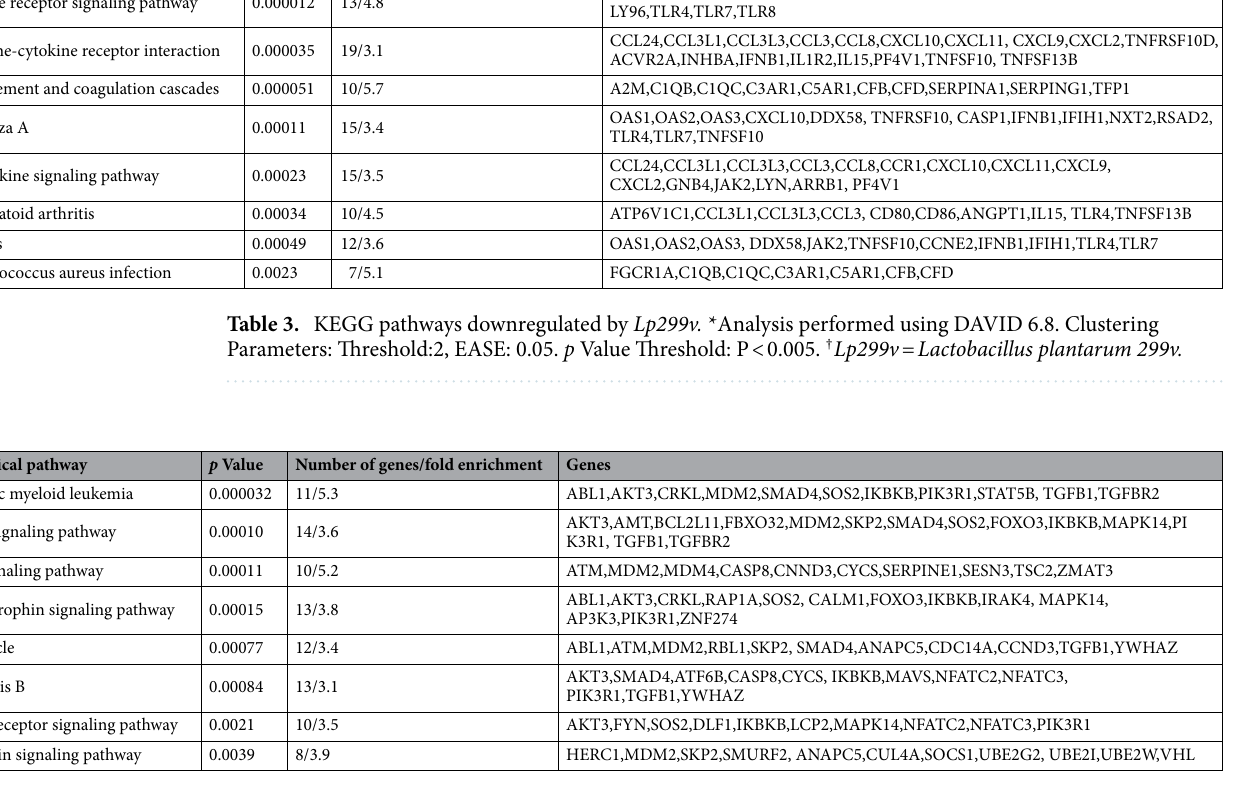
Table 4. KEGG pathways upregulated by Lp299v. *Analysis performed using DAVID 6.8. Clustering Parameters: Threshold:2, EASE: 0.05. p Value Threshold: P < 0.005. † Lp299v = Lactobacillus plantarum